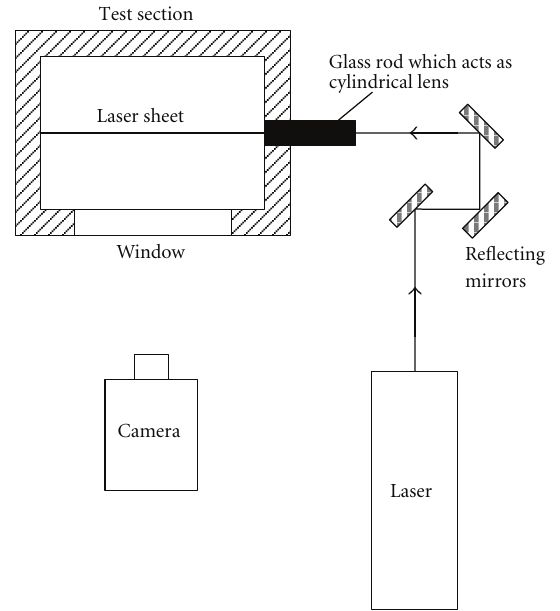
Figure 2: Test section, laser Sheet and